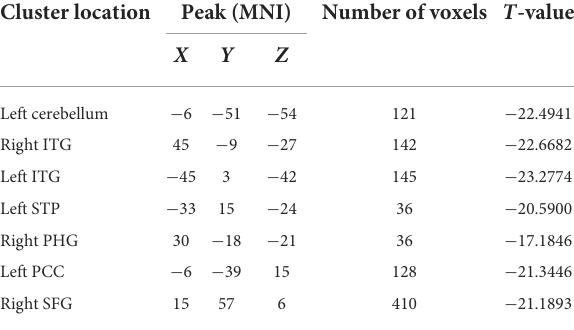
control groups, with age and sex being treated as covariates. TABLE 2 Clusters with abnormal regional homogeneity in the patients with